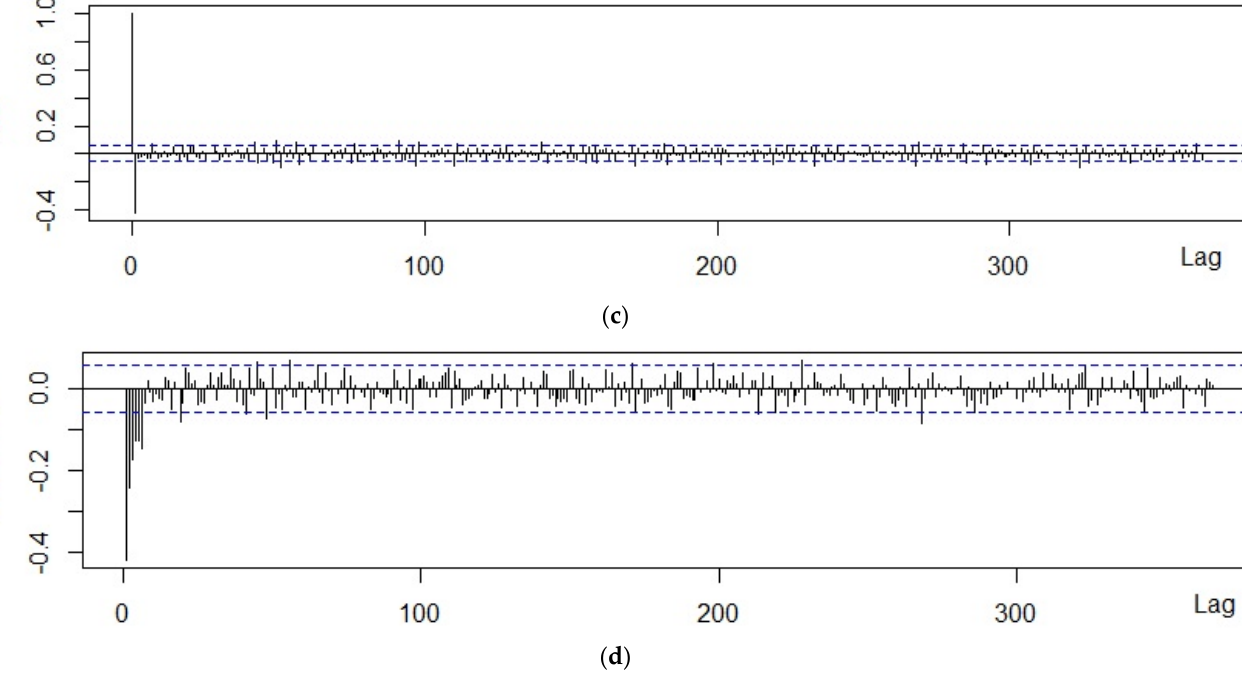
Figure A3. Autocorrelation function (ACF) of the Moran’s I b for Sugar prices of the original time series ( a ) and of the first differences ( c ); Partial autocorrelation function (PACF) of the Moran’s I b for Sugar prices of the original time series ( b ) and of the first differences ( d ). The Moran’s I b indexes are calculated based on binary contiguity matrices.